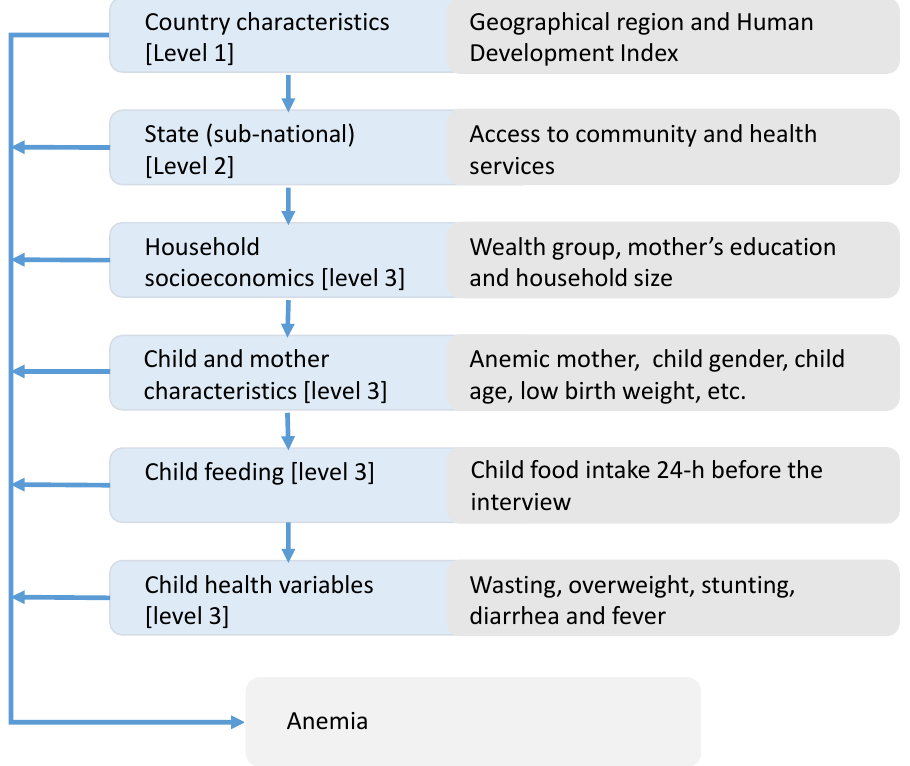
Figure 1. The hierarchy of the determinants of infant anaemia—conceptual framework for the multilevel